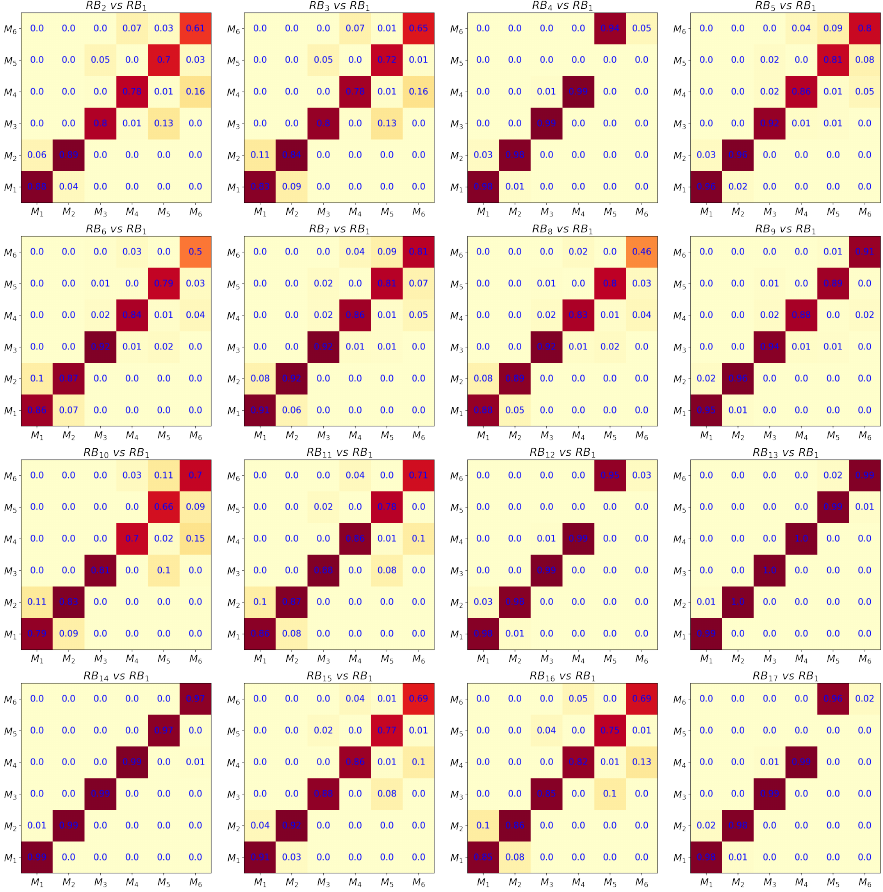
Figure 7. Modal Assurance Criterion matrices when comparing the model reduced basis—RB— (of the first thickness choice) with the remaining 16 reduced modal bases for the other thickness